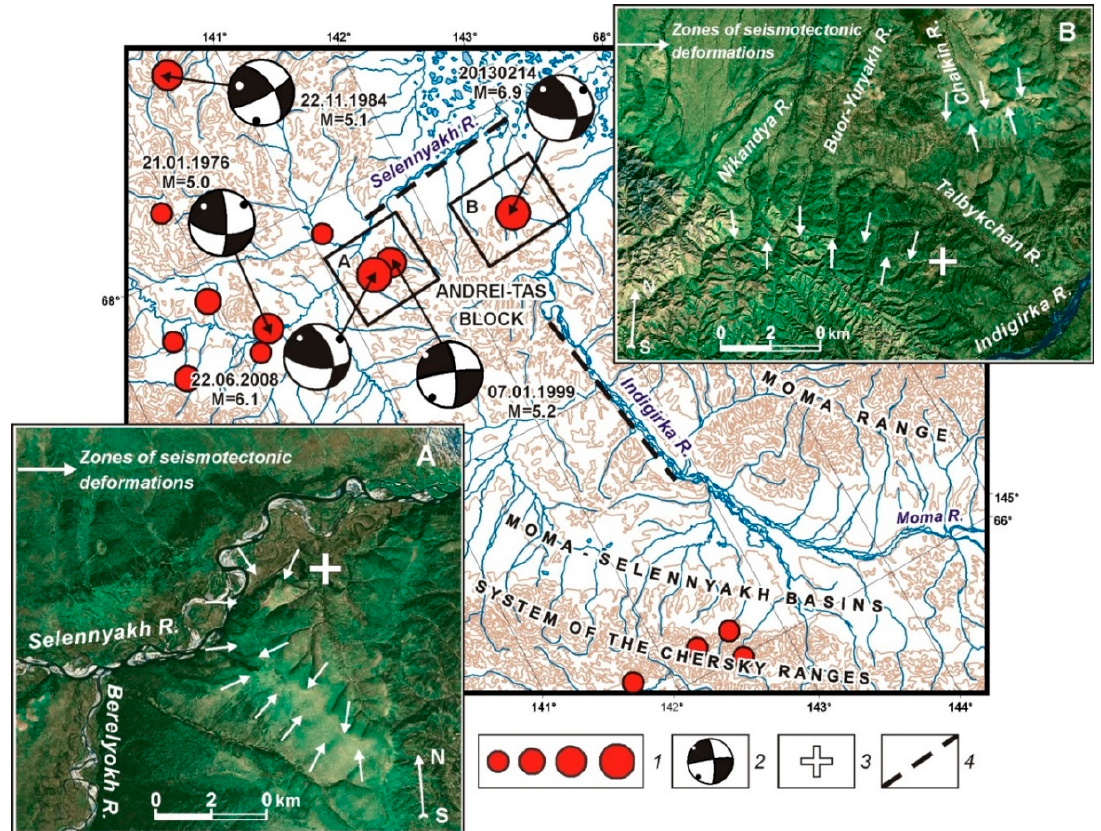
Figure 10. Strong earthquakes in the Andrei–Tas area of maximum seismic activity values (after [30,31]). 1—earthquake epicenters sized by magnitude: 3.0–3.9, 4.0–4.9, 5.0–5.9, 6.0–6.9; 2—focal mechanisms, dates and magnitudes of earthquakes (lower hemisphere; the principal stress axes of compression and extension are marked by black and white dots, respectively); 3—Andrei-Tas earthquake epicenter of 22 June 2008 (inset A ) and Ilin–Tas (Abyi) earthquake epicenter of 14 February 2013 (inset B ); 4—zones of seismogravity effects The insets show seismotectonic deformation structures resulting from the earthquakes.